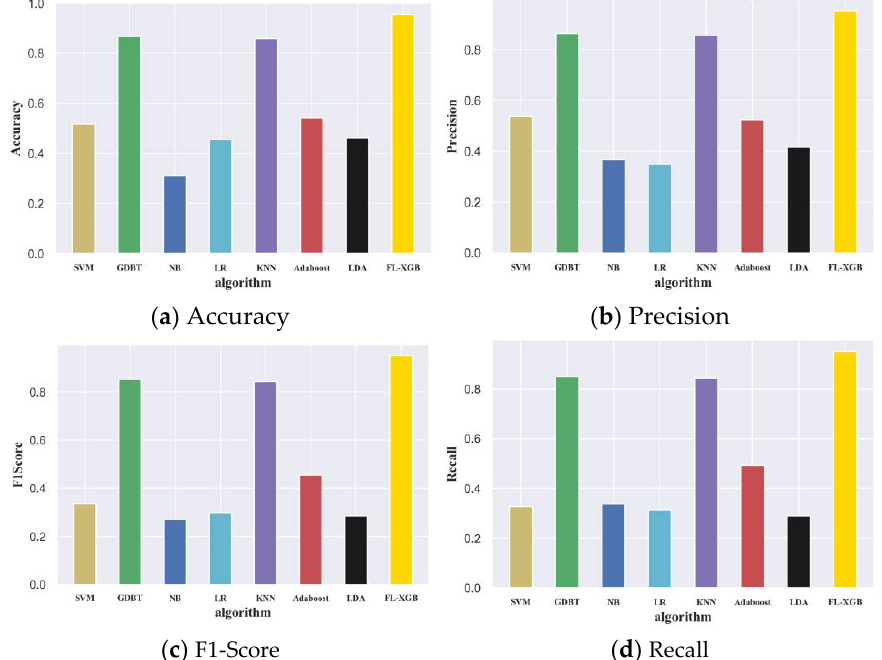
Figure 16. Performance comparison chart of different algorithms.